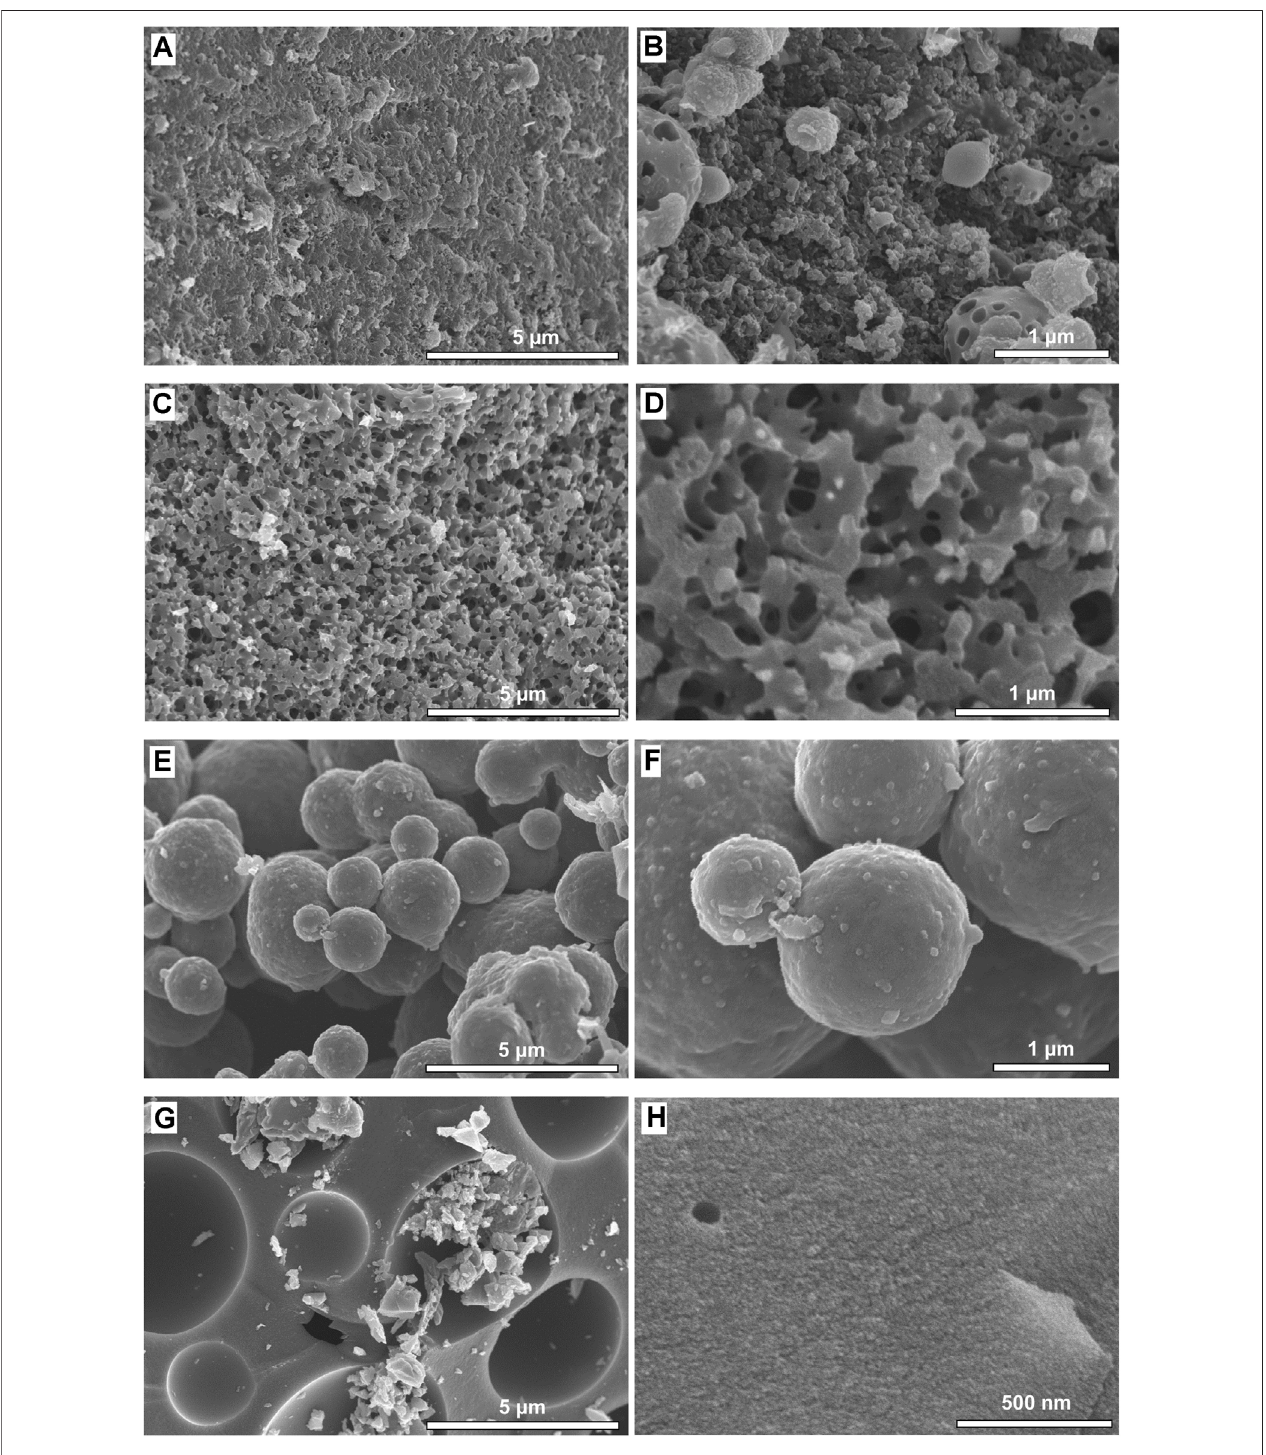
FIGURE 4 | SEM images of lignin carbon aerogels; (A,B) CA-L87, (C,D) CA-L81, (E,F) CA-L68, and (G,H) CA-L56, showing the effect of lignin content on surface morphology microstructure and porosity.